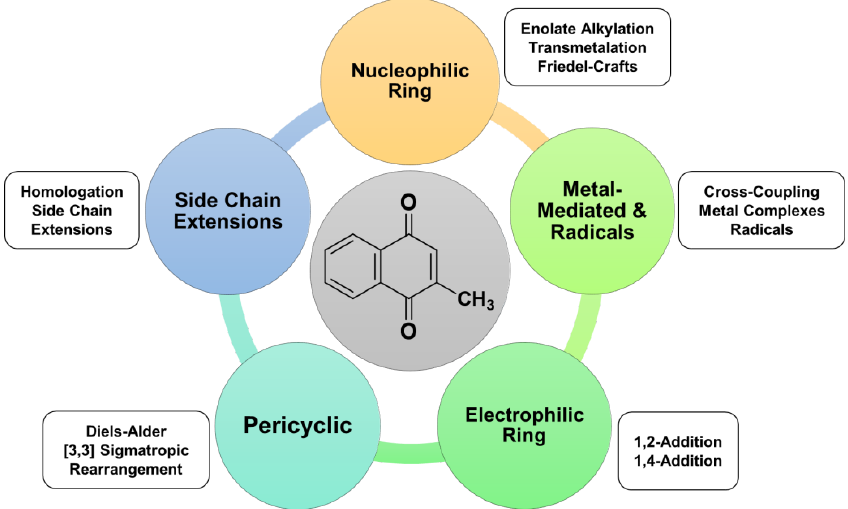
Figure 3. 5 Main synthetic strategies from across the literature for the synthesis of menaquinone